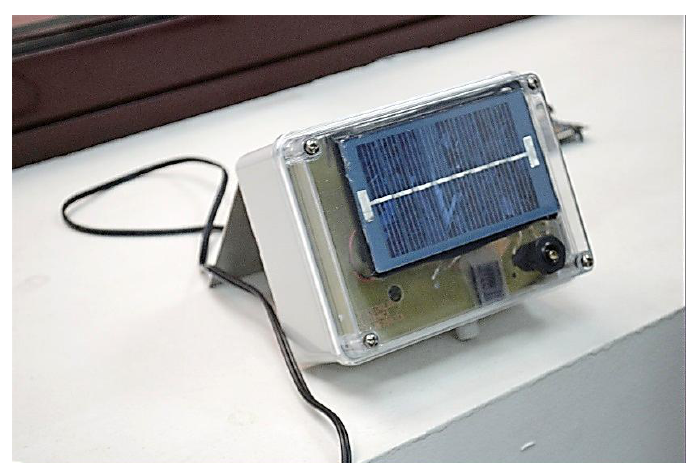
Figure 5. Node of the ARTICA 2 network.